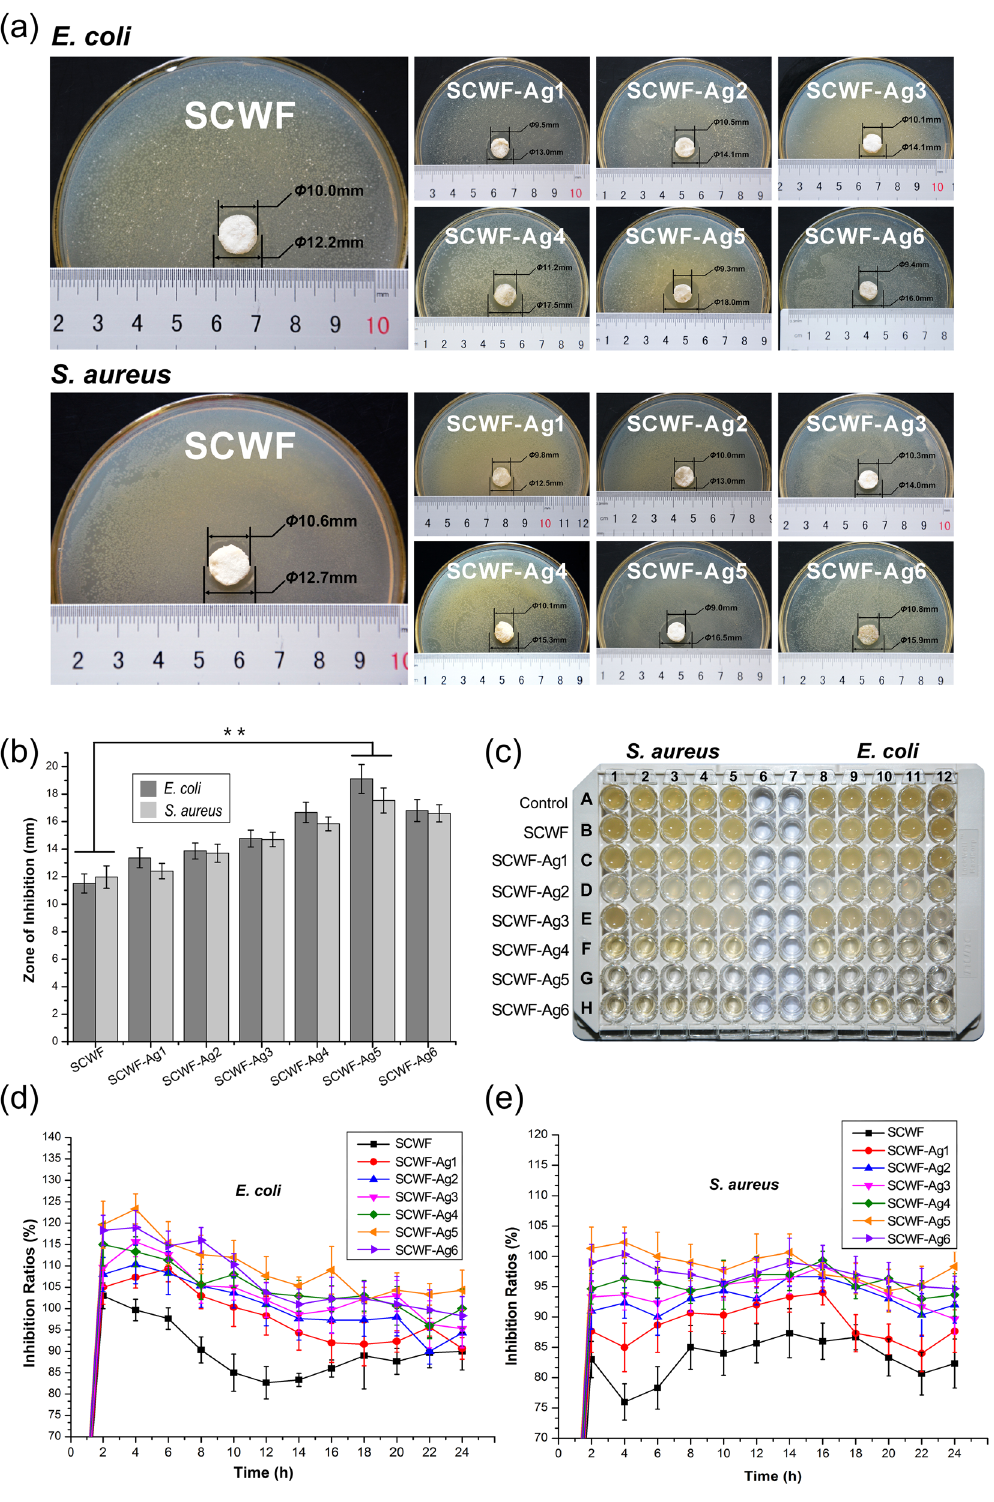
Figure 5. Anti-bacterial performance of SCWF-AgNPs. ( a ) Inhibition zones of SCWF and SCWF-Ag1–6 after 24 h incubation at 37 °C. ( b ) Zone of inhibition diameters (mm) of SCWF/SCWF-AgNP samples against S. aureus and E. coli after incubation for 24 h ( ** P < 0.01). ( c ) The 96-well plate image of bacteria in broth media after being directly in contact with SCWF or SCWF-Ag1–6 for 24 h. Inhibition ratio kinetic curves of SCWF and SCWF-Ag1–6 against S. aureus ( d ) and E. coli ( e ). The error bars denote the standard error of the mean (n =